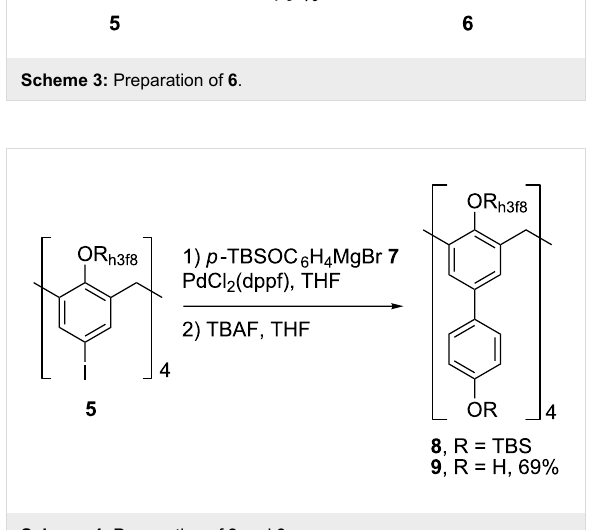
Scheme 4: Preparation of 8 and 9